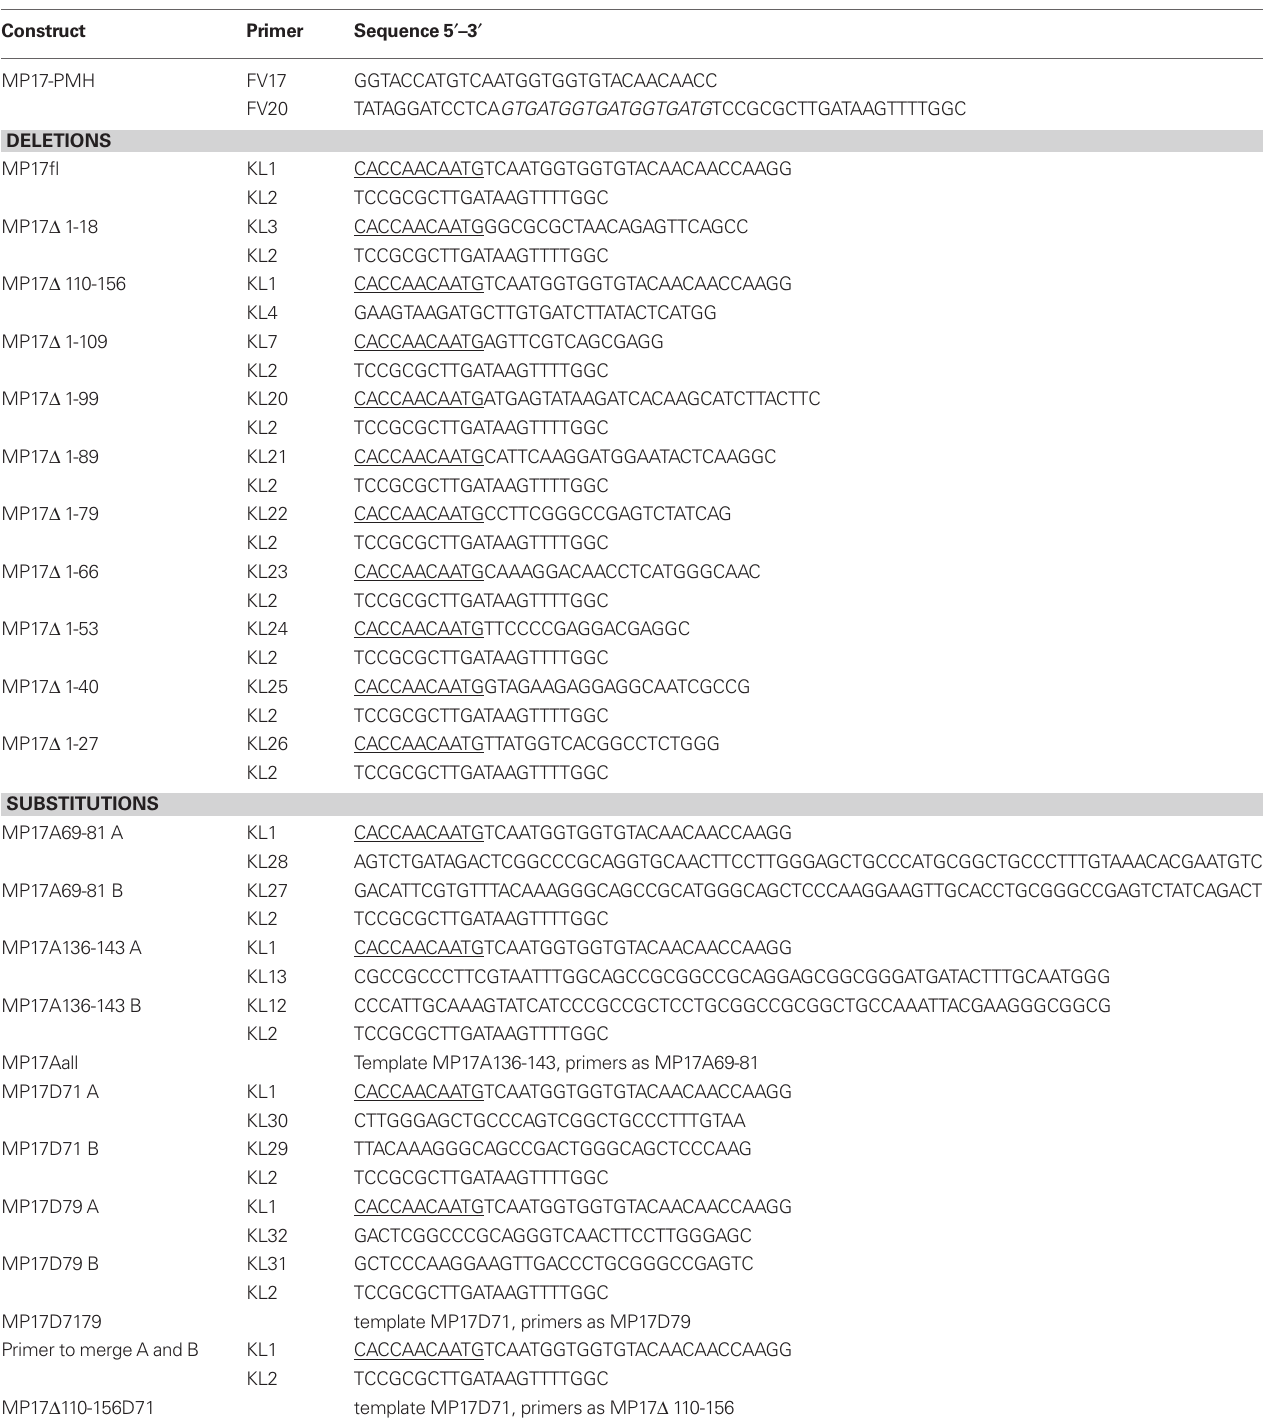
Table 2 | Primer used in this